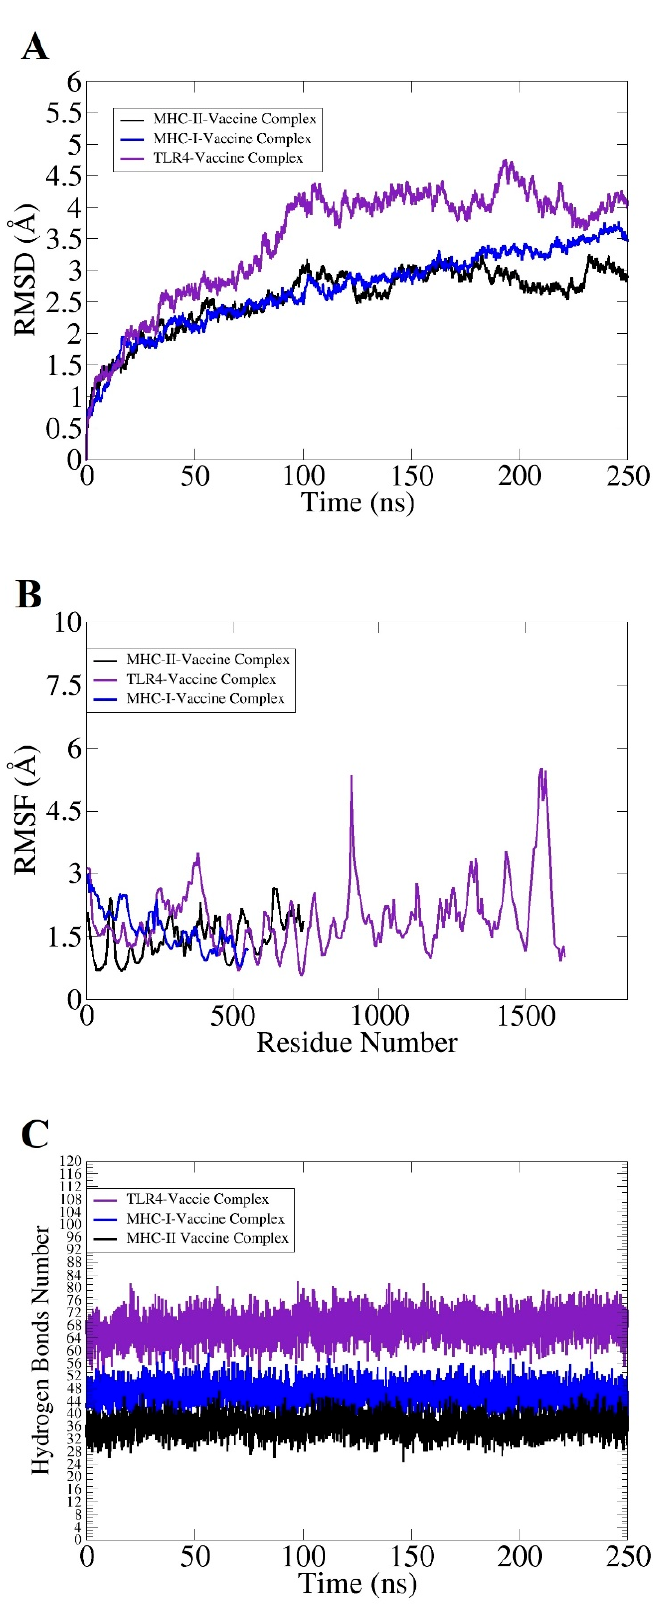
Figure 10. Statistical analysis of molecular dynamic simulation: ( A ) root mean square deviation (RMSD), ( B ) root square fluctuation (RMSF), and ( C ) hydrogen bonding analysis.